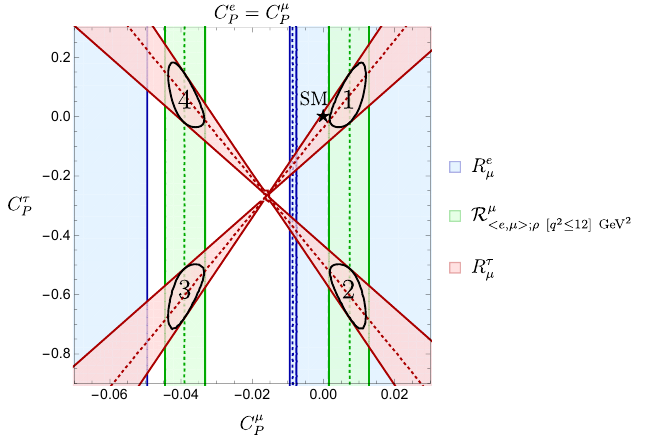
µ – C τ plane utilizing the ratios R e P P